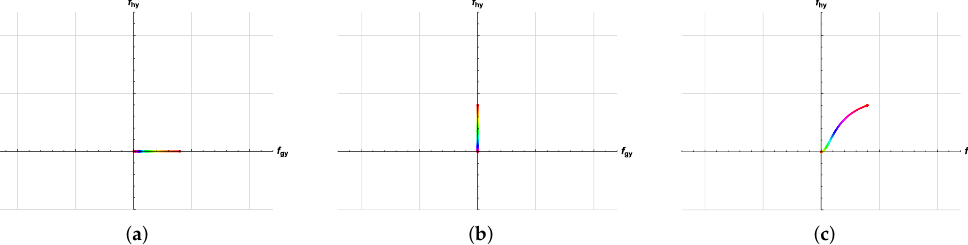
Figure 3. Fault detectability indexes on the fault information manifold. ( a ) F D ( f gy ) ; ( b ) F D ( f hy ) ; ( c ) F D ( f 1 ) .